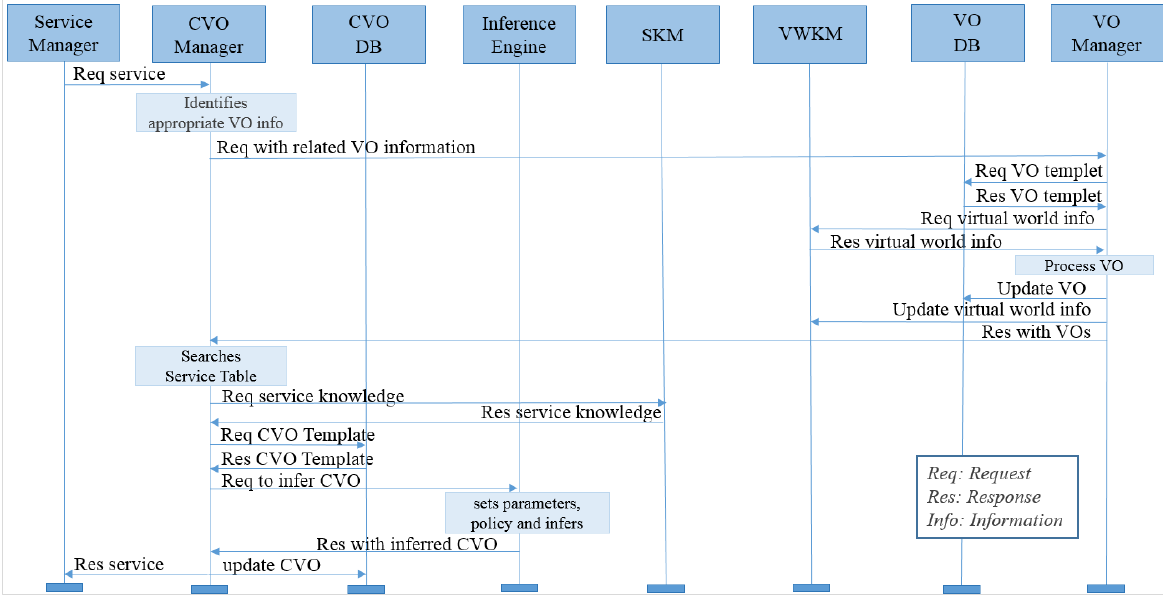
Figure 16. Knowledge-based service execution